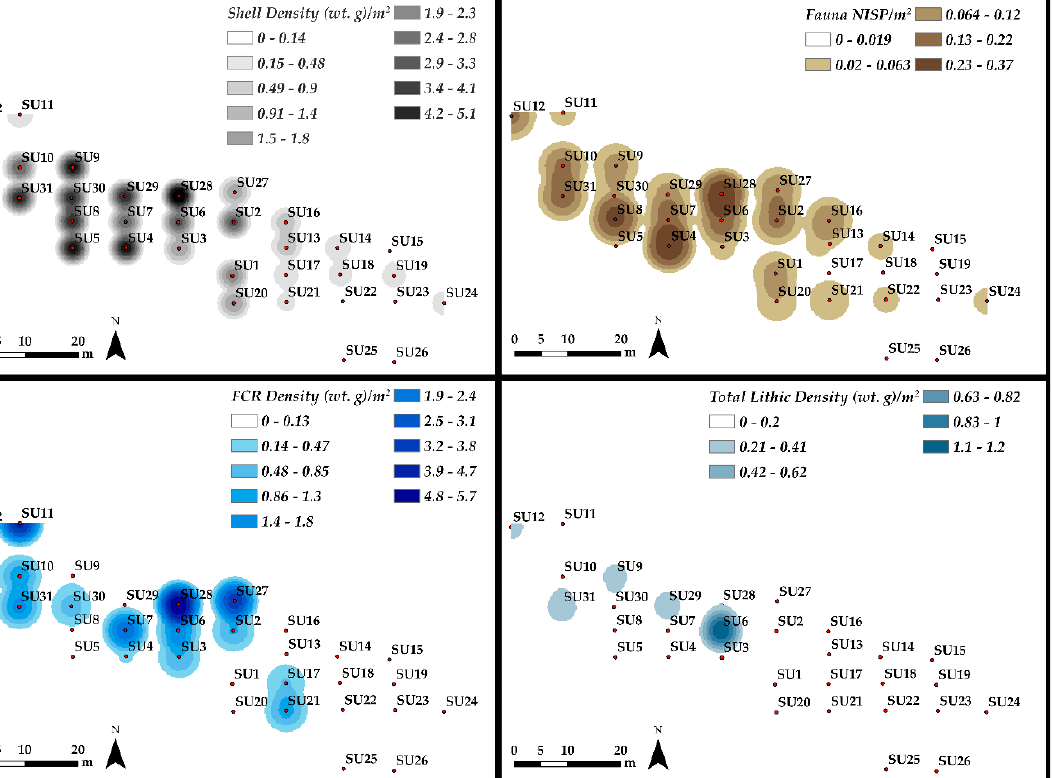
Figure 2. Density maps of surface survey data by material type. FCR: fire-cracked rock. NISP: number of identified speci- mens.